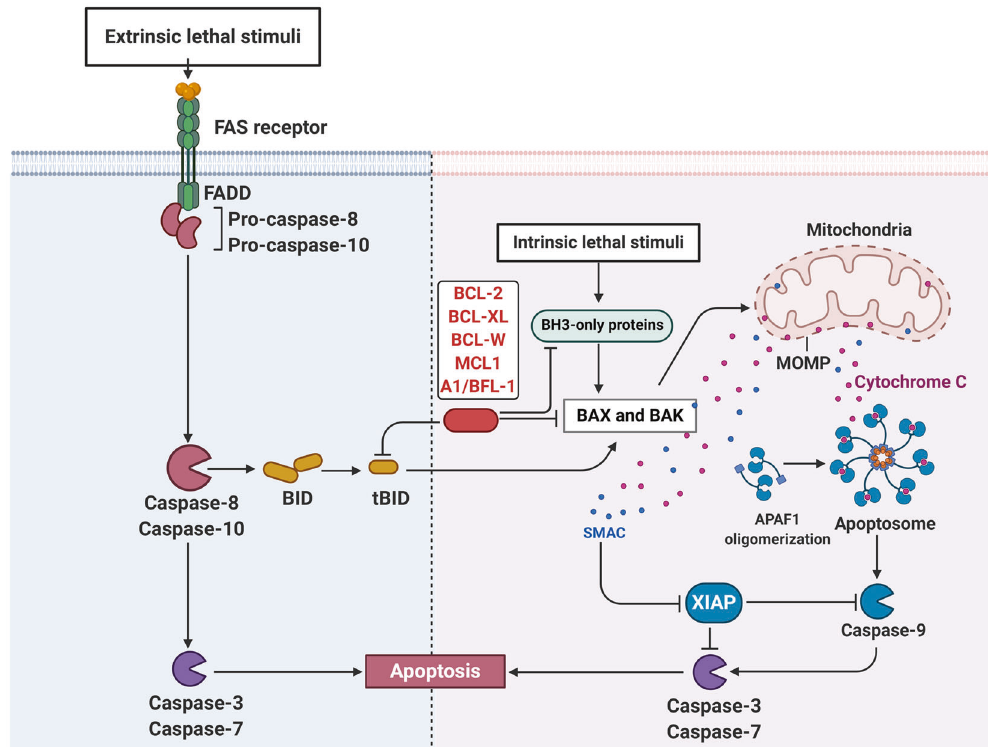
Fig. 4 Schematic illustration of extrinsic and intrinsic pathways of apoptosis. In healthy cells, anti-apoptotic BCL-2 proteins (BCL-2, BCL-XL, BCL-W, MCL-1, and A1/BFL-1) bind to and inhibit activators (BH3-only proteins) and effectors (BAX and BAK). Treatment with BCL-2 inhibitors releases the inhibitory effects of anti-apoptotic BCL-2 proteins on activators and effectors. The subsequent activation and oligomerization of the pro-apoptotic proteins BAK and BAX result in the formation of mitochondrial outer membrane permeabilization (MOMP) and the release of cytochrome C as well as a second mitochondria-derived activator of caspase (SMAC) from the mitochondria. Cytochrome C can form a complex with procaspase 9 and apoptosis protease-activating factor 1 (APAF1), thereby activating caspase 9. Caspase 9 then activates procaspase 3 and procaspase 7, resulting in cell apoptosis. Figure created with